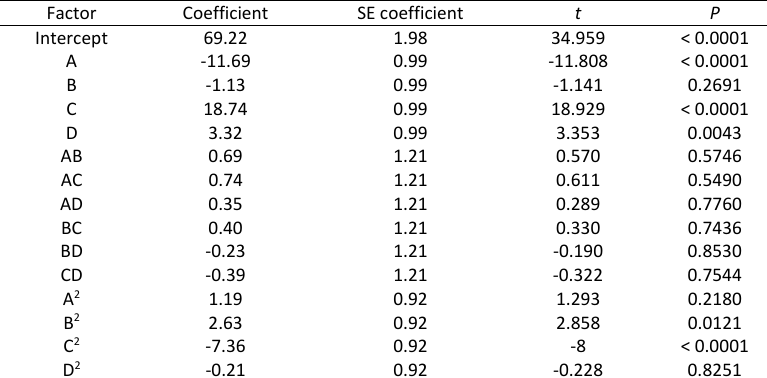
process of AO10 2